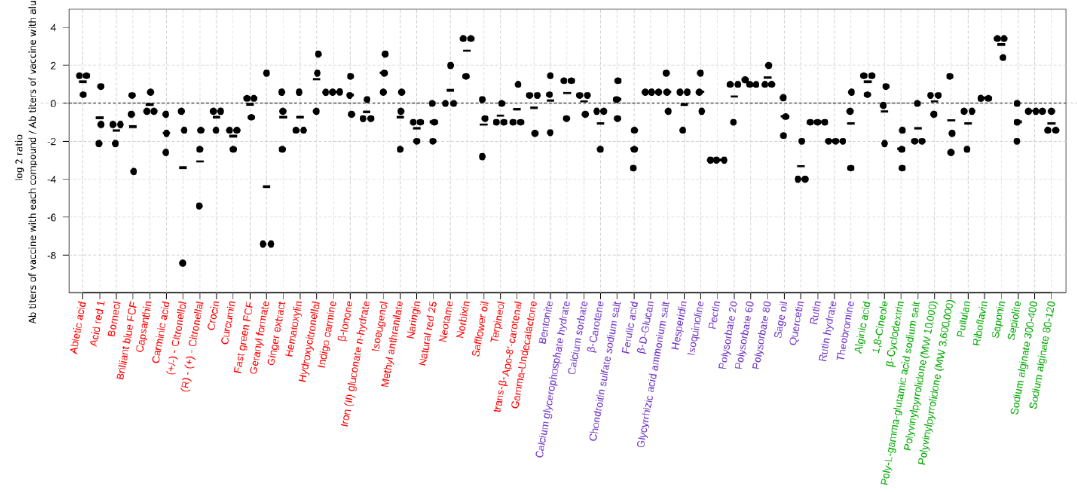
Figure 1. Virus-specific antibody titers induced in mice by the 59 hit compounds in combination with the HA vaccine. Six-week-old BALB / c mice were immunized with the influenza HA vaccine with or without compounds twice with a two-week interval between the vaccinations. Blood samples were collected two weeks after the second immunization. Virus-specific antibodies were measured by using an ELISA with inactivated and purified CA07 virus as the coating antigen. Depicted are the antibody titers obtained from the mice immunized with the vaccine with the hit compounds. Each dot represents one mouse, and the individual antibody titers were divided by the average of the antibody titers of the mice immunized with the vaccine plus alum in the same batch. This procedure normalizes the values of the animals immunized with candidate compounds to their respective positive controls, and the log transformation aids in the representation of the values. Values above zero indicate that the antibody titers of the mice treated with the vaccine plus the hit compounds were higher than those of their positive controls. The black horizontal line represents the mean antibody titers from individual mice ( n = 3, except sage oil n = 4). The dotted line represents the reference vaccine plus alum. The status of the 59 hits is indicated by the color used for the compound names: red compound names represent novel adjuvant candidates; blue compound names represent novel adjuvant candidates for the influenza vaccine; compounds with green names indicate that their adjuvant e ff ect for the influenza vaccine has been reported previously. MW: molecular weight.